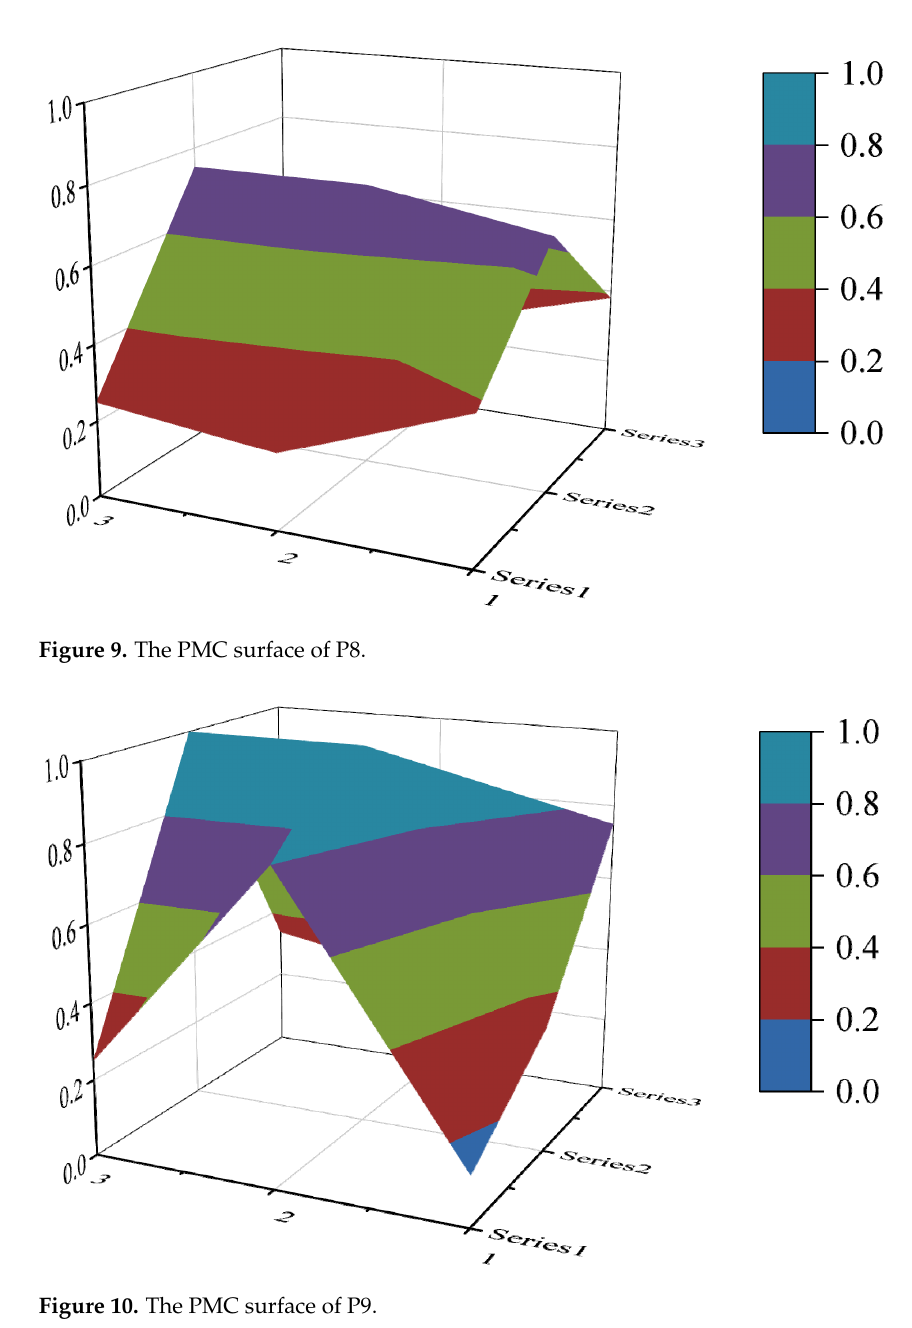
Figure 8. The PMC surface of P7.